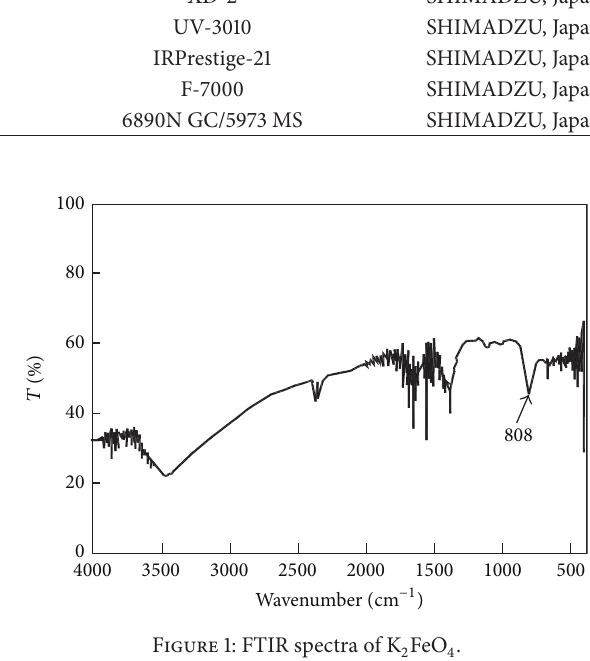
Figure 1: FTIR spectra of K 2 FeO 4 .